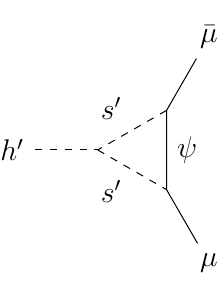
Figure 5 . The one-loop contribution to the Higgs decay into muon pair, present in Higgs-portal Figure 7: The one-loop contribution to the Higgs decay into muon pair, present in models with VLL-muon interaction. This decay channel is forbidden in our model due to the Higgs-portal models with VLL-muon interaction. This decay channel is forbidden scale in our model due to the scale symmetry.